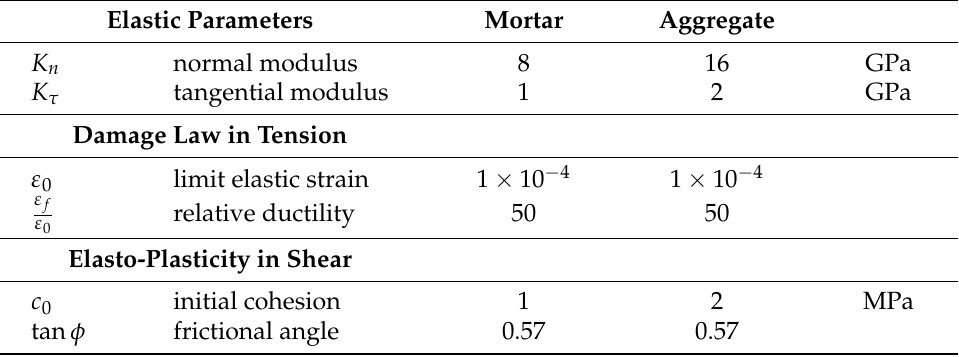
Figure 2. Voxelized concrete sample ( left ) and the corresponding DEM sample ( right ) ( D min = 15 mm, D max = 30 mm) considered in the uniaxial compression simulation. Table 1. Summary of model parameters required for the calibration of the DEM